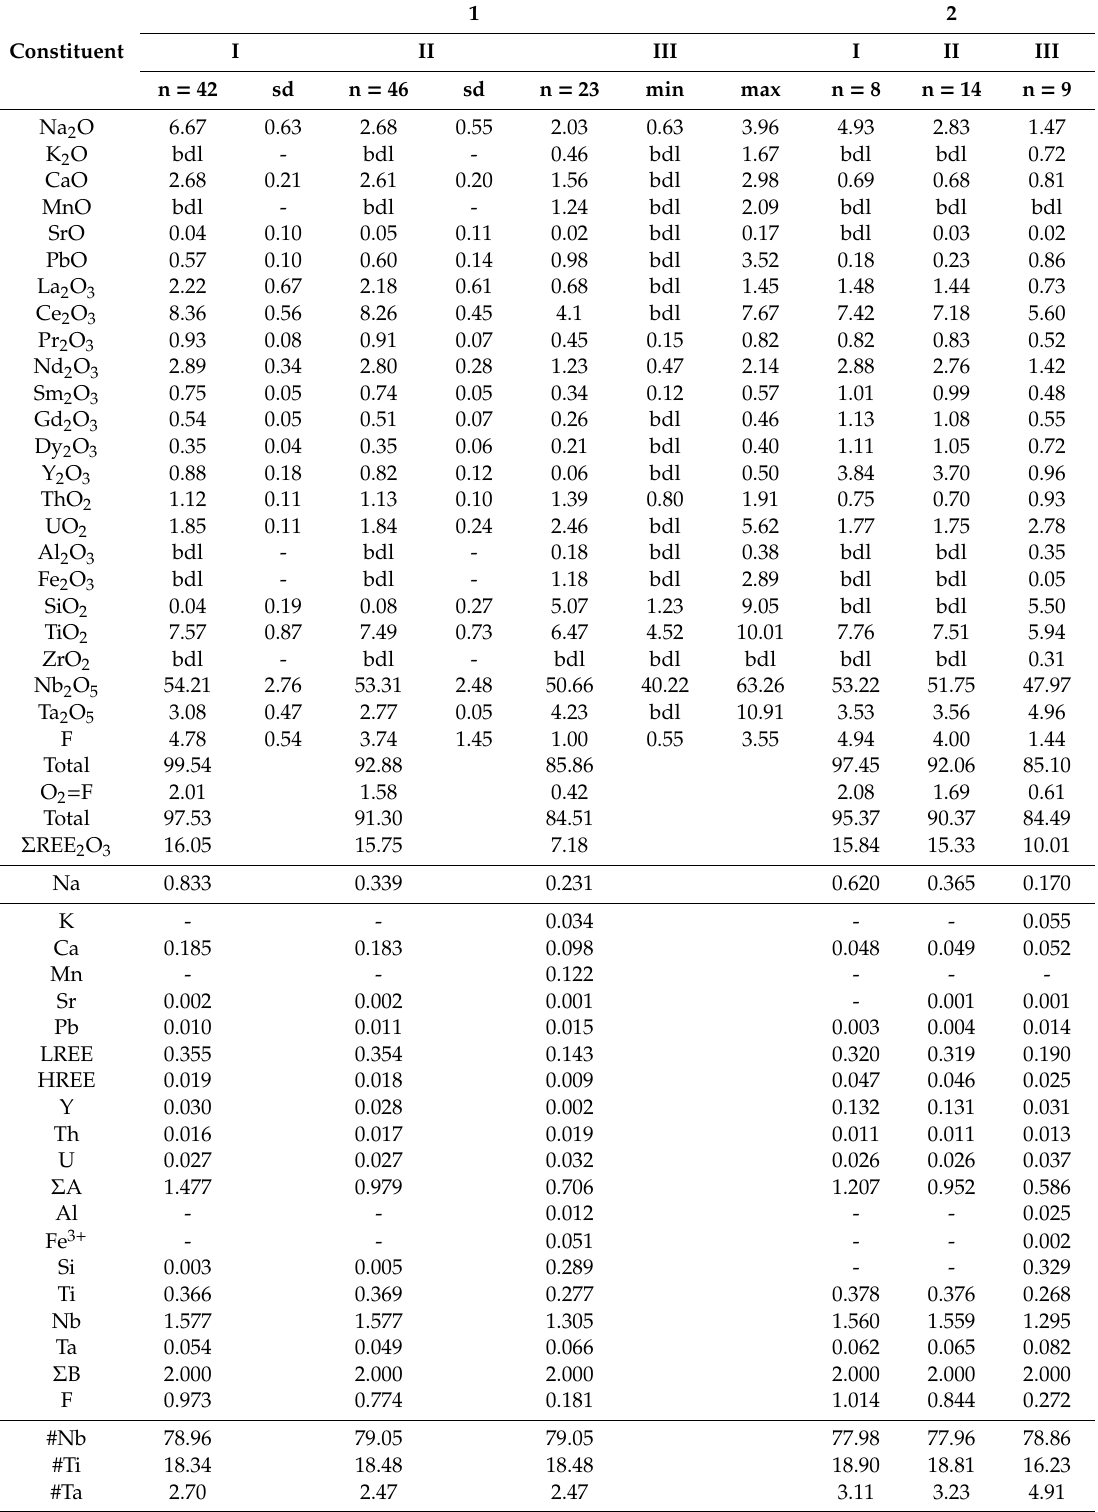
Table 3. Chemistry (wt.%) of pyrochlore-group minerals from the Katugin aegirine granites (WDS analyses).